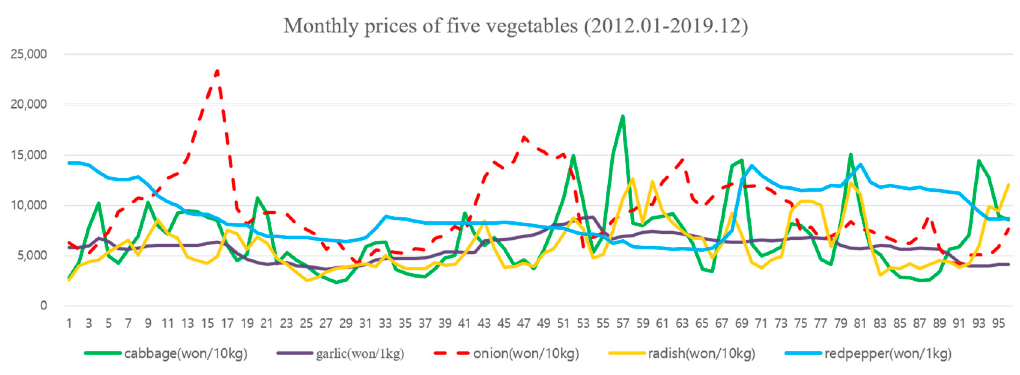
Figure 3. Monthly prices of five vegetables from January 2012 to December 2019.